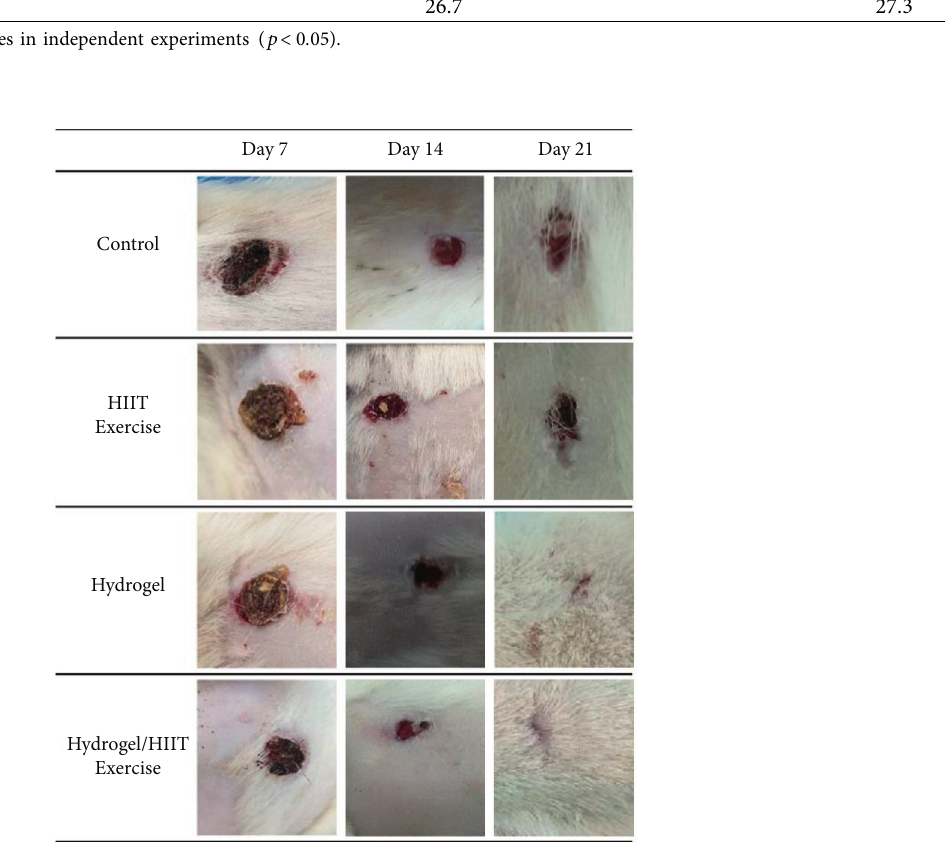
Figure 2: Macroscopic evaluation of the control, HIIT exercise, hydrogel, and hydrogel/HIIT exercise groups on days 7, 14, and